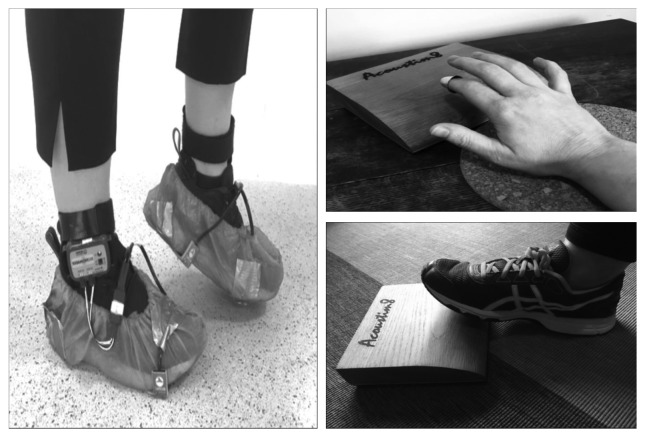
Stepping on the spot and finger- and toe-tapping equipment and actions.